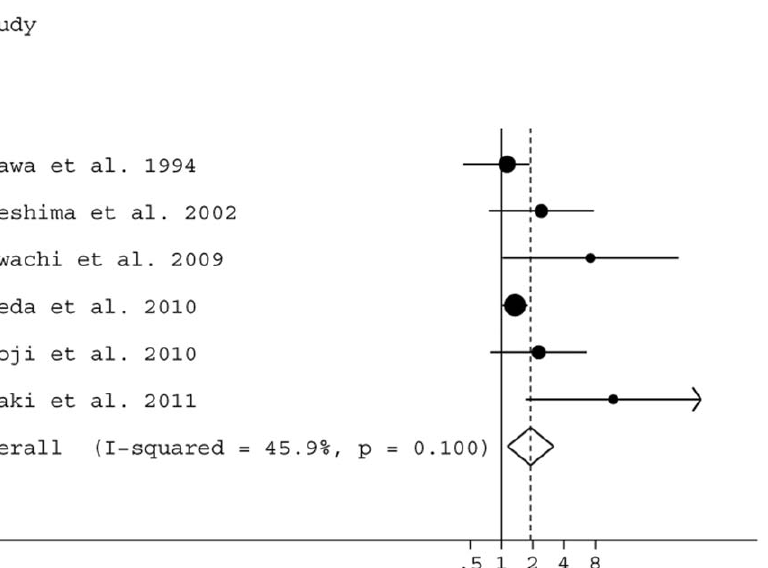
Figure 3. Forest plot showing the combined relative hazard ratio for relapse-free survival of stage I patients by multivariate analysis.